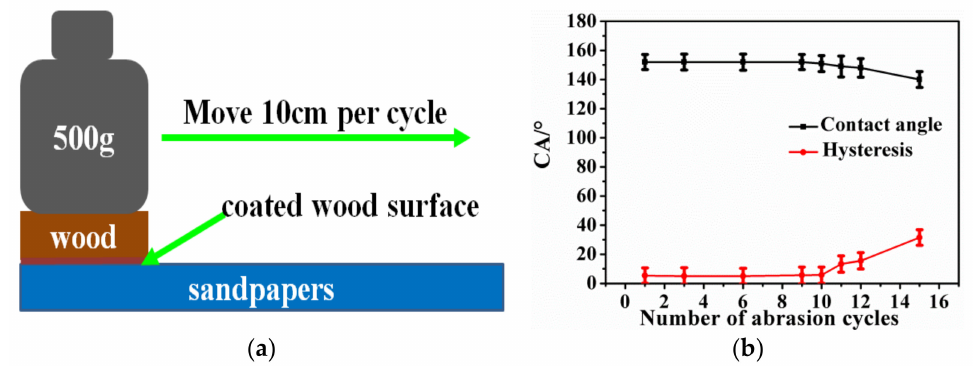
Figure 6. ( a ) Illustration of the abrasion test for the surface under 500 g of loading on sandpaper (240 grit); ( b ) Water CAs as a function of the number of abrasion